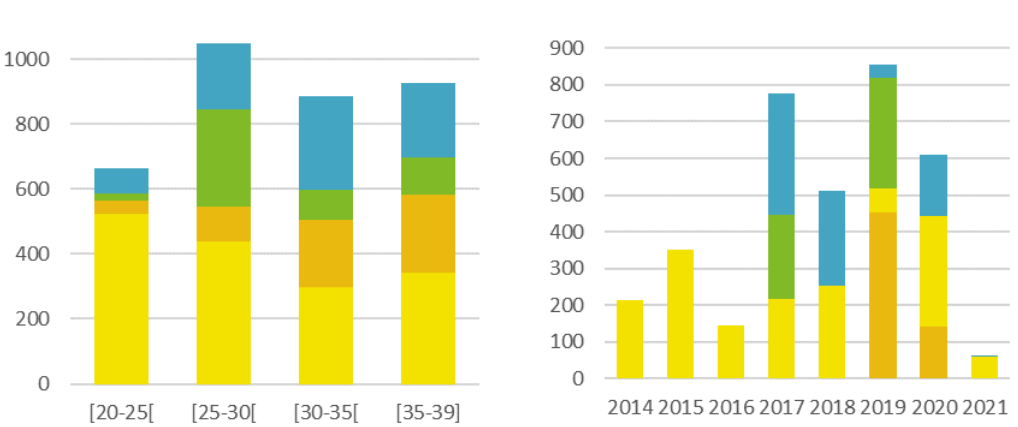
Figure 2. Age distribution and sample collection years covered per European region for children, teenagers and adults.